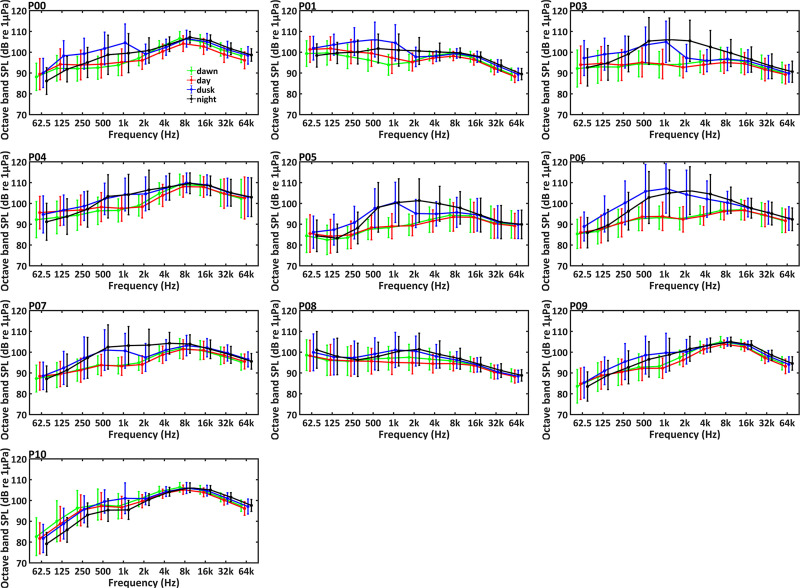
Daily trends of octave band sound pressure levels (octave band SPLs) for different frequency bands during one year at the PAM sites.Differences among dawn, day, dusk and night are marked with *** for p-level < 0.001; ** for p-level < 0.005; * for p-level < 0.05 (Kruskal-Wallis test).